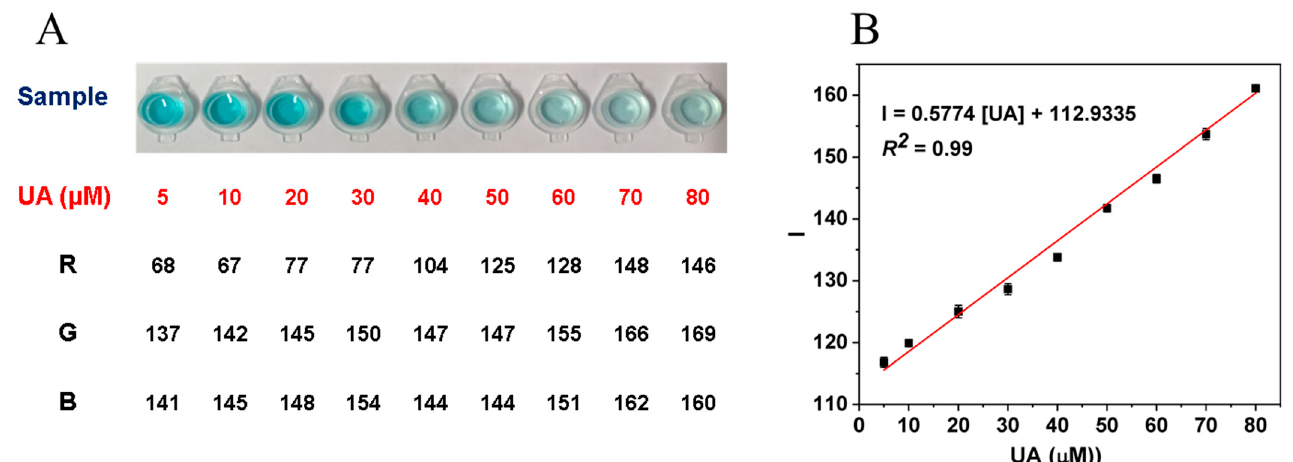
Figure 6. ( A ) Color changes in the TpBpy COF + TMB system and the corresponding RGB value with various content of UA (Red words represent different concentrations of UA). ( B ) The linear response of color intensity acquired by the RGB mode under different UA